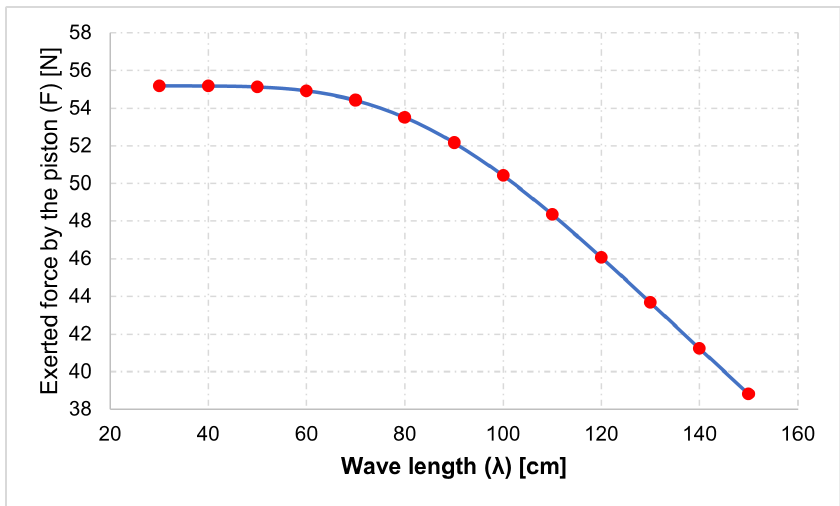
Figure 8. Force exerted by the piston-type wavemaker for the range of wave